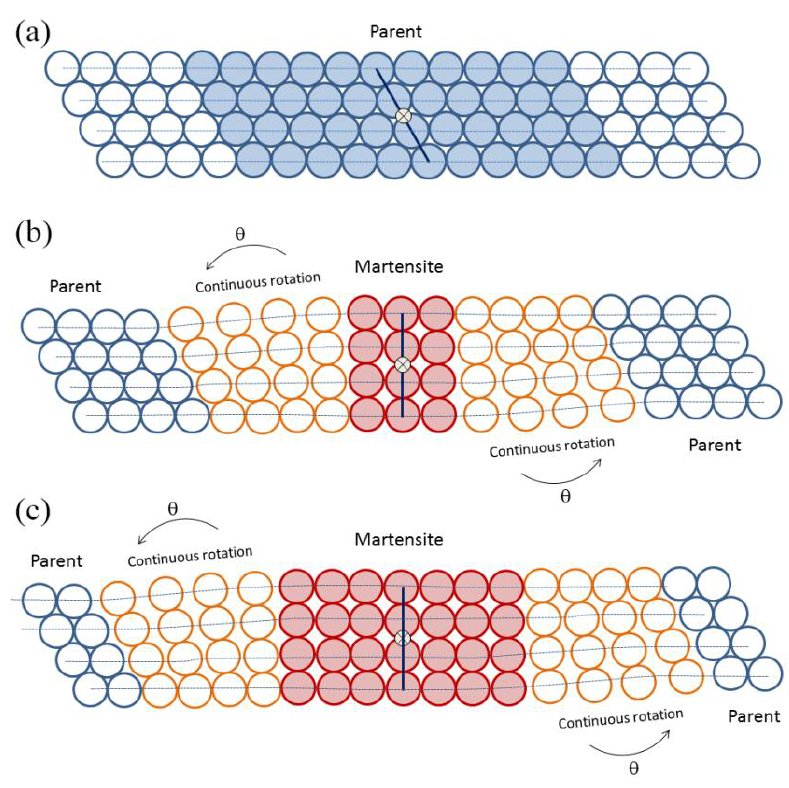
Figure 12. Schematic representation of a 2D hexagonal ⟶ square displacive transformation, viewed